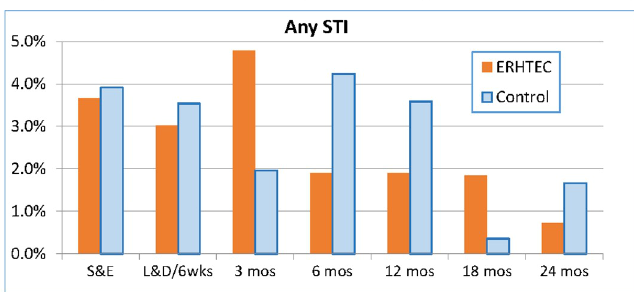
Fig 6. a. Proportions of women testing positive for syphilis antibodies over follow-up Difference in average change by treatment assignment: p = 0.136 Difference in average follow-up level by treatment assignment: p = 0.266 b. Proportions of women testing positive for Neisseria gonorrhea over follow-up Difference in average change by treatment assignment: p = 0.632 Difference in average follow-up level by treatment assignment: p = 0.785 c. Proportions of women testing positive for Chlamydia trachomatis over follow-up Difference in average change by treatment assignment: p = 0.543 Difference in average follow-up level by treatment assignment: p = 0.595 d. Proportions of women testing positive for Trichomonas vaginalis over follow-up Difference in average change by treatment assignment: p = 0.051 Difference in average follow-up level by treatment assignment: p = 0.367 e. Proportions of women testing positive for any of the STIs tested over follow-up Difference in average change by treatment assignment: p = 0.681 Difference in average follow-up level by treatment assignment: p = 0.753.